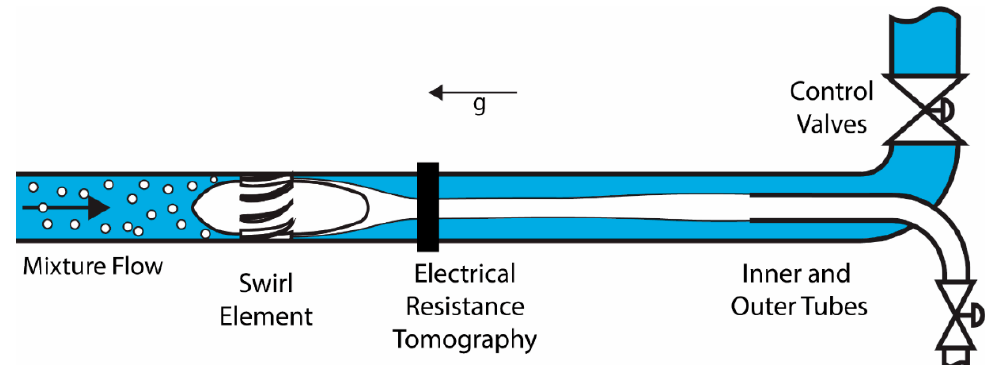
Figure 1. Swirl Separator Schematics. An air-water separation is represented, where the air is rendered in white and water in blue. Changes in the gas core observed at the ERT location propagate to the inner and outer tubes. The separator is installed vertical, and 𝑔 represents the direction of the gravity vector in relation to the equipment.